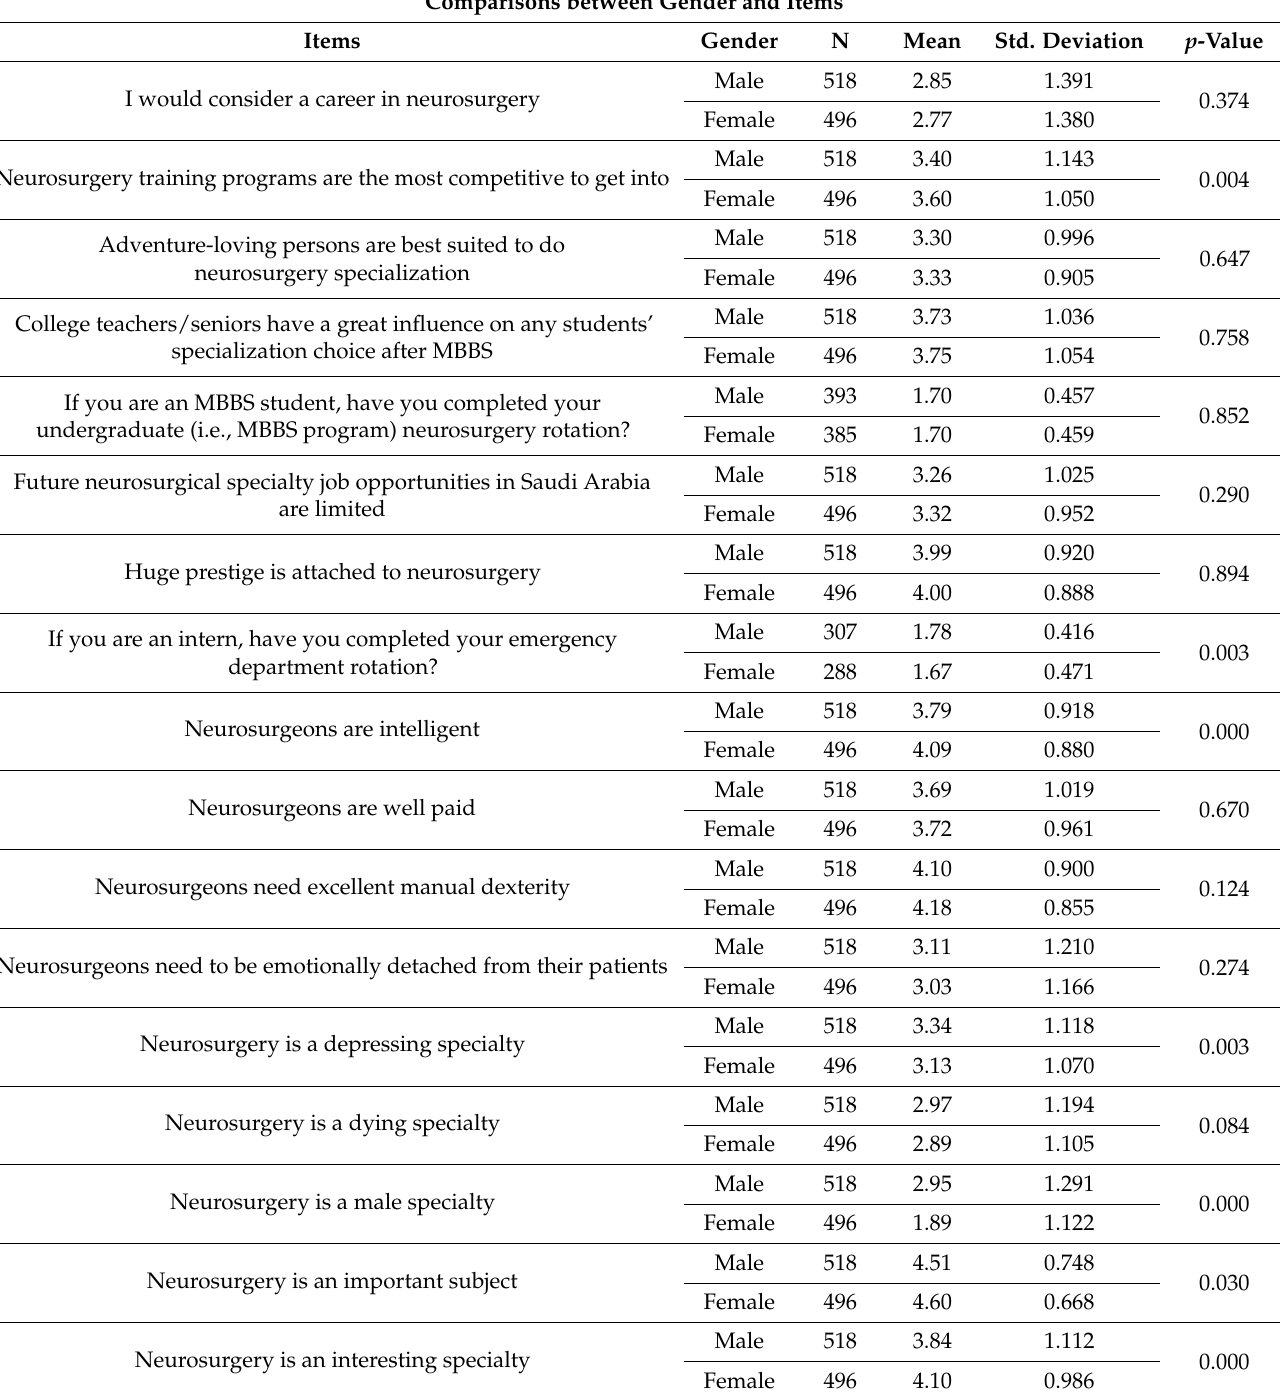
Table 2. Comparison of the item responses between the male and female respondents. Comparisons between Gender and Items Items Gender N Mean Std. Deviation p